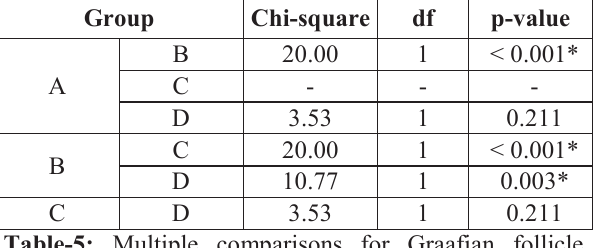
Table-5: Multiple comparisons for Graafian follicle among the groups. (*p value ≤ 0.05 is